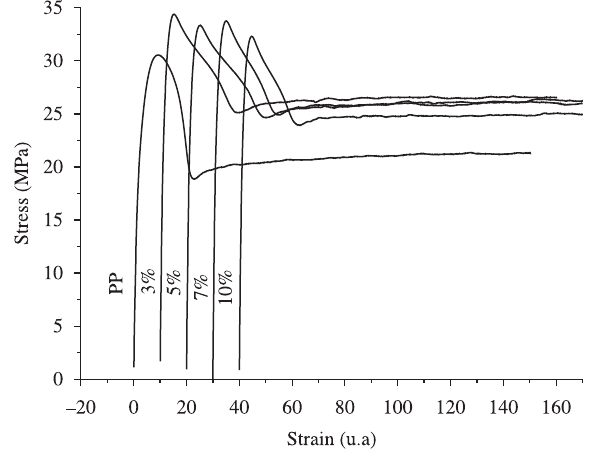
nanocomposites. 3